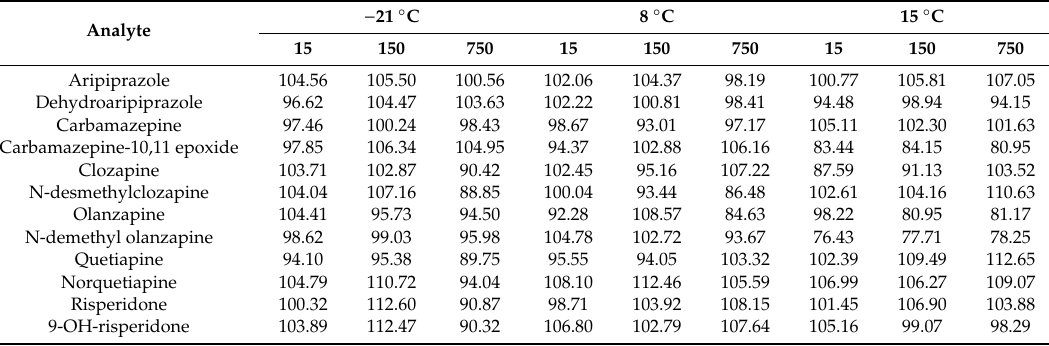
Table 2. Stability of analytes in spiked saliva stored in a refrigerator at 8 ◦ C and after freeze–thaw cycles at − 21 ◦ C. The stability of the extracts was maintained in an autosampler at 15 ◦ C. The values in the table reflect the analyte concentrations as a percentage of the amount determined on the first day of the